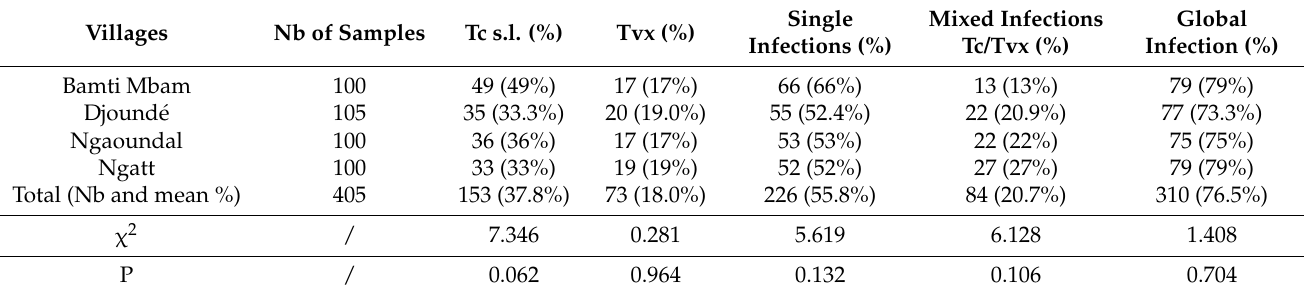
Table 1. Trypanosome infection rates of cattle using Very Diag